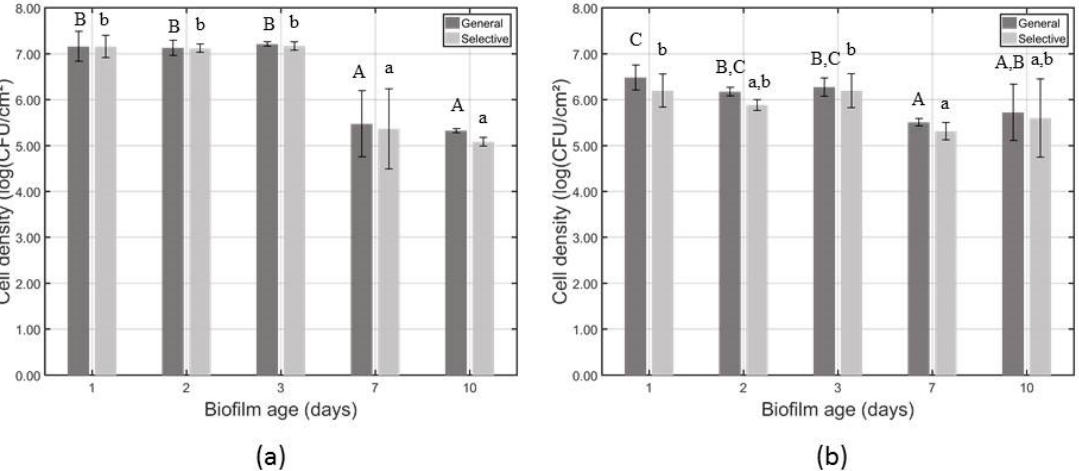
Figure 3. Cell density (log(CFU/cm 2 )) determined on general and selective medium for the untreated ( a ) L. monocytogenes and ( b ) S. Typhimurium biofilms following 1, 2, 3, 7, and 10 day(s) of incubation. Bars bearing different letters (no capital or small letters in common for the general and the selective medium, respectively) are significantly different ( p ≤ 0.05).